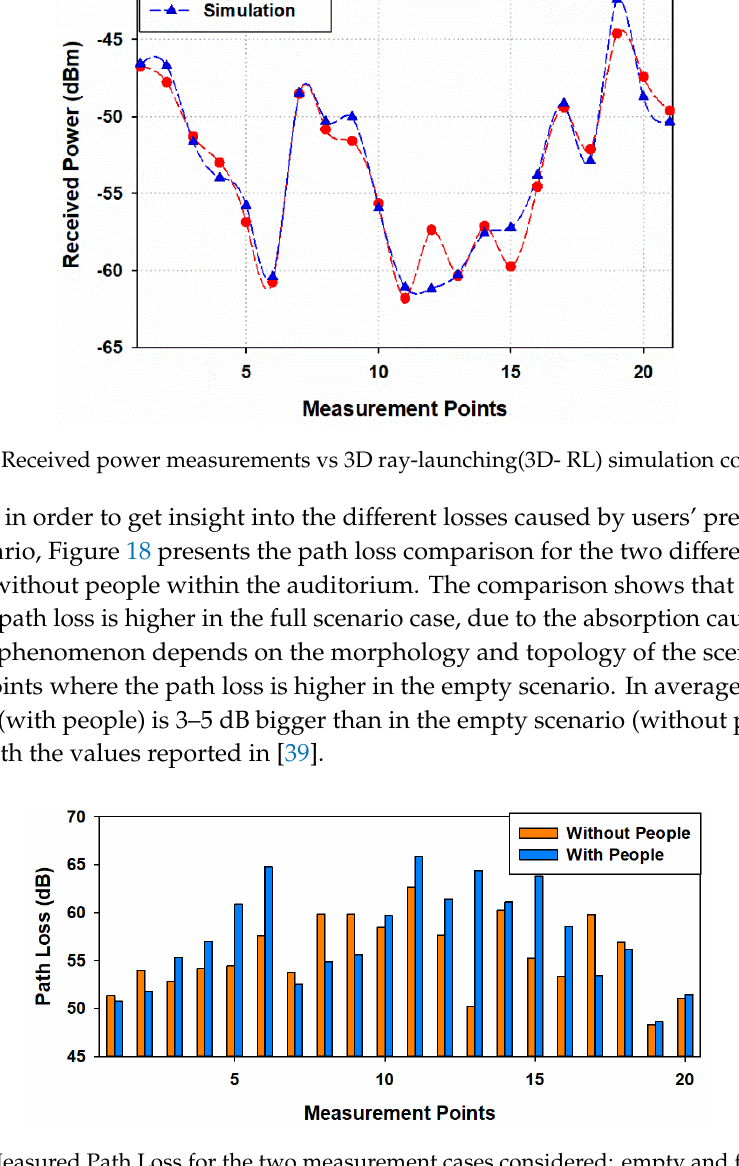
Figure 18. Measured Path Loss for the two measurement cases considered: empty and full